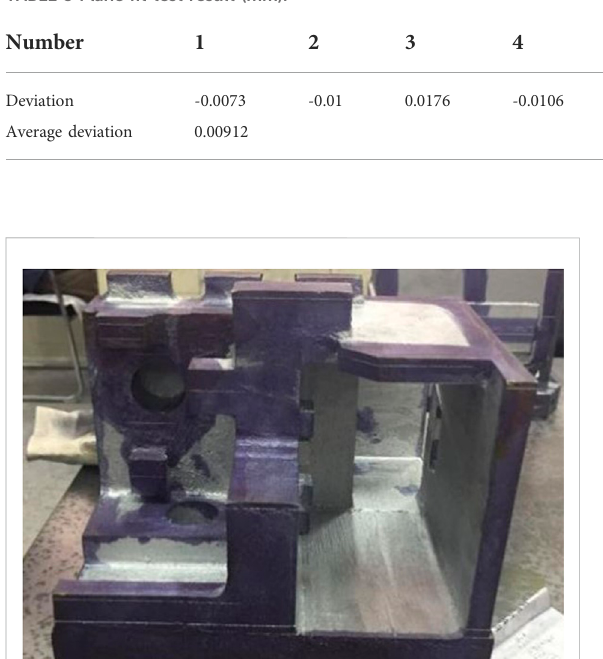
FIGURE 7 Alignment results.